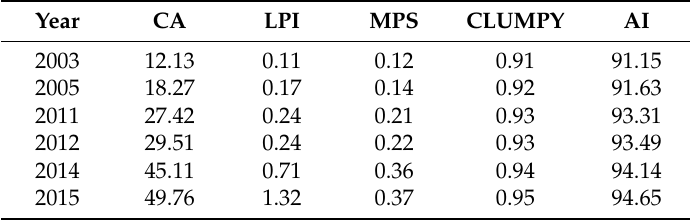
Table 4. Landscape metrics of S. alterniflora on the margins of mangrove forests from 2003 to 2015. Year CA